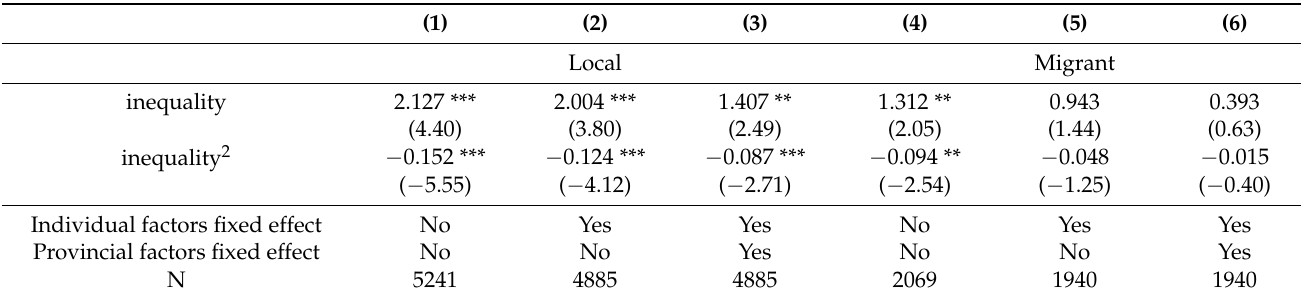
Table 9. The effect of individual-level income inequality on subjective environmental pollution: differences between the locals and migrants.